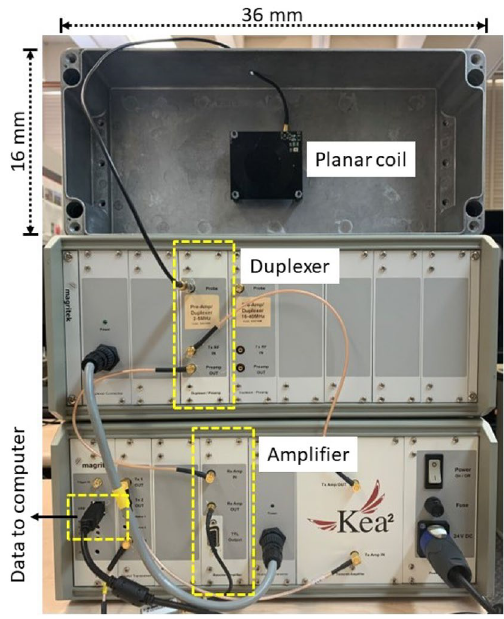
Figure 3. The experimental setup for detecting psychoactive drugs consists of a custom planar coil, a Magritek Kea2 benchtop spectrometer with an internal receiver, and a duplexer. The spectrometer is connected to a computer to collect data.